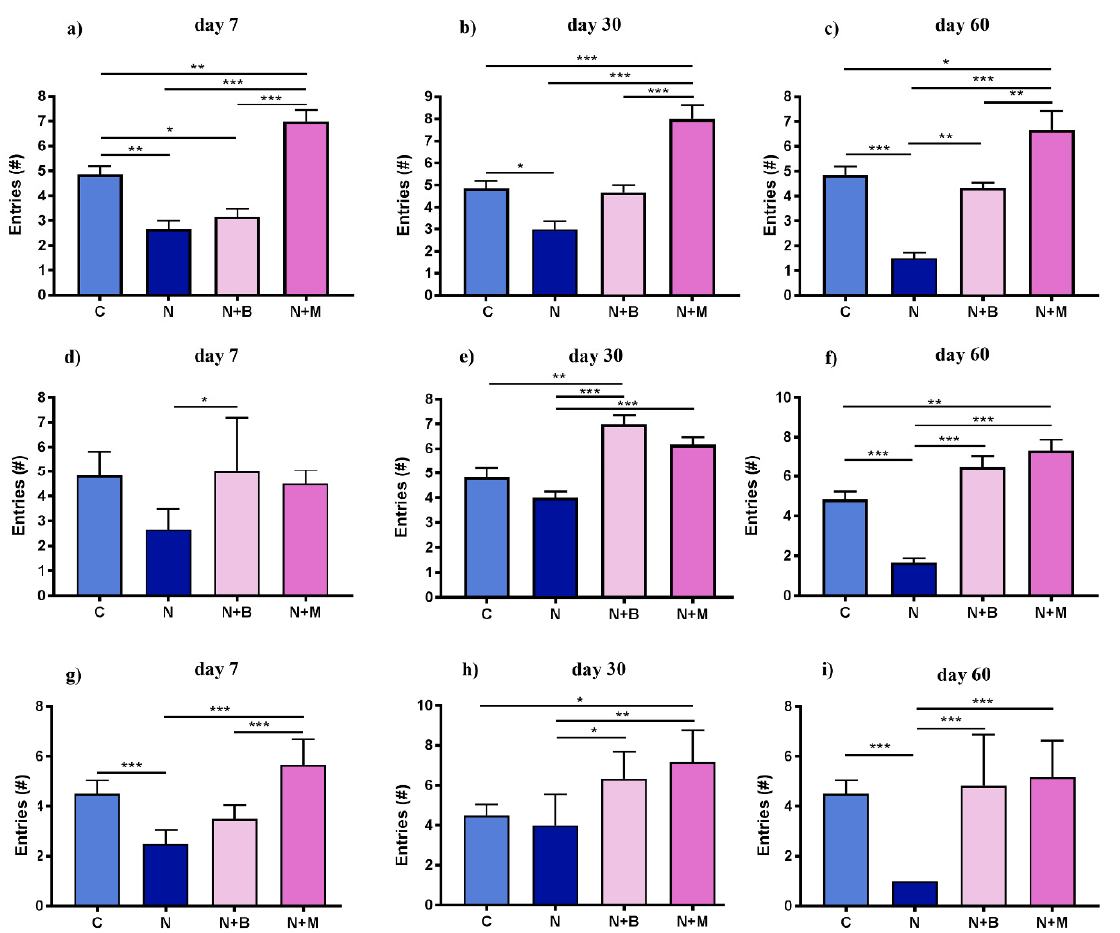
Figure 5. Number of entries to the A–C zones in a Y-maze. Animals ( n = 6) were treated for 60 days with noise (N) or left untreated (C). Mesedin (M) and beditin (B) were injected daily i.p. to the rats exposed to chronic noise (N + M and N + B, respectively). One-way ANOVA with Sidak’s multiple comparison test, * p < 0.05, ** p < 0.01, *** p < 0.001. The mean ± SEM values of number of entries to the A zone on days 7, 30, and 60 of noise exposure and mesedin/beditin are shown in ( a ), ( b ), and ( c ), respectively. The mean ± SEM values of number of entries to the B zone on days 7, 30, and 60 of noise exposure and mesedin/beditin are shown in ( d ), ( e ), and ( f ), respectively. The mean ± SEM values of number of entries to the C zone on days 7, 30, and 60 of noise exposure and mesedin/beditin are shown in ( g ), ( h ), and ( i ), respectively.